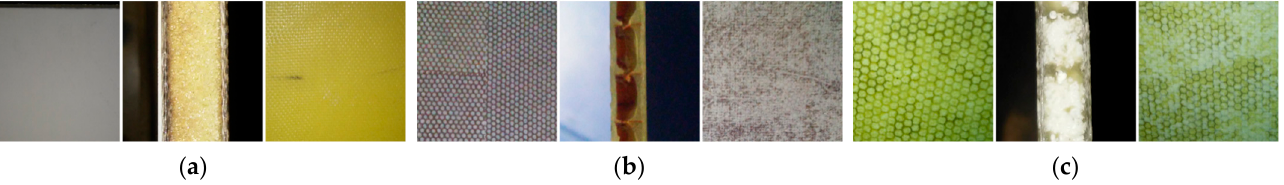
Figure 4. Samples of three-layer glued radio-transparent material: ( a ) Sample № 1—with foam plastic filling; ( b ) Sample № 2—with a filling layer of honeycomb material; ( c ) Sample № 3—with a filling layer of honeycomb structure material, the cells of which are filled with glass spheres.